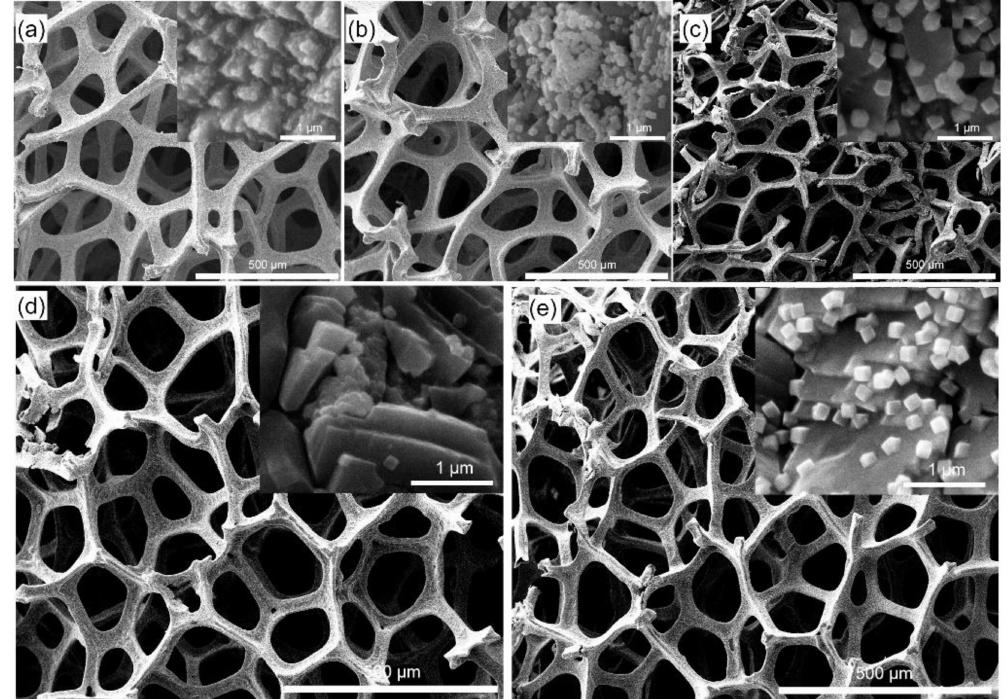
Figure 3. SEM characterization of Cu foam immersed into a mixture aqueous solution of FeCl3 (0.01 g mL − 1 ) and HCl (0.1 M) at room temperature (scale bar = 500 µ m). Numbers ( a – e ) stand for the immersion time for 5, 10, 15, 20, and 25 min, respectively. The insets ( a – e ) show the nanoscale patterns on the microscale roughness surface. The insets with a scale bar of 1 µ m show the enlarged view of the